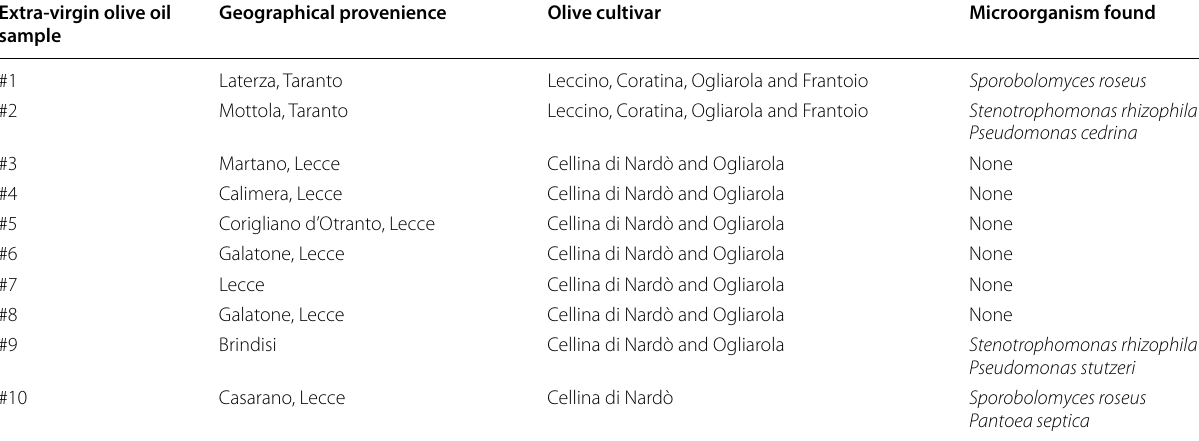
Table 1 Properties of olive oil samples and microbial isolates Extra-virgin olive oil